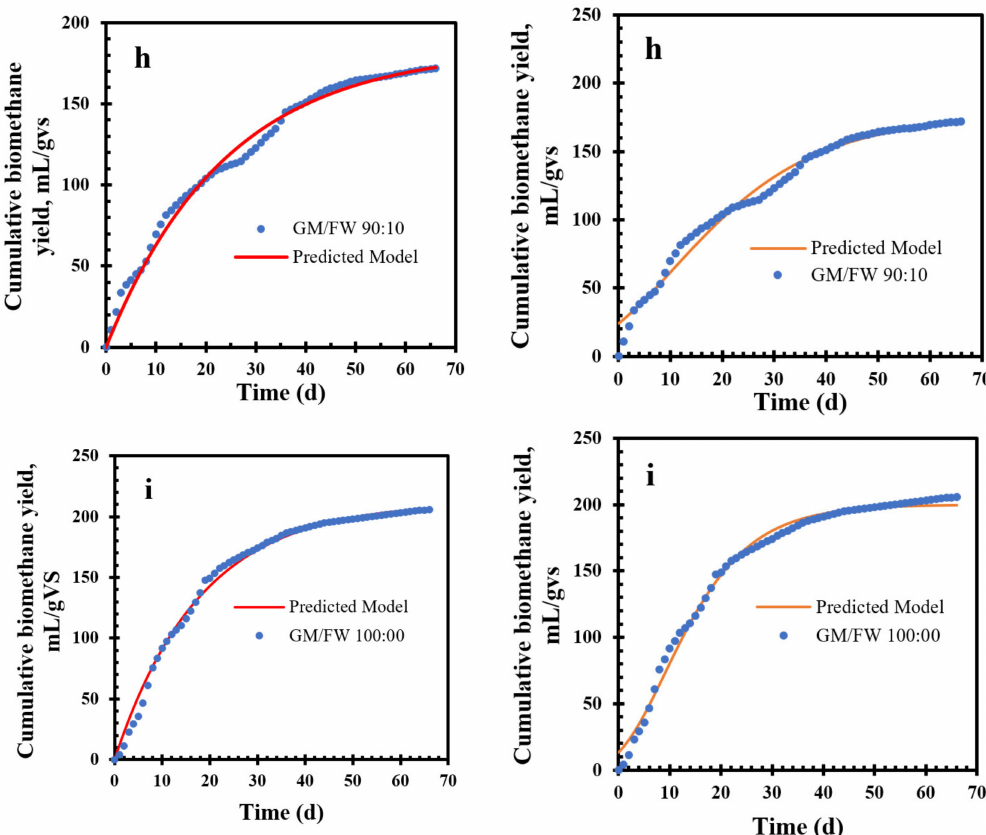
Figure 3. The experimental and predicted biomethane yields for GM/FW ratios; a: 0:100, b: 10:90; c: 30:70; d: 40:60, e: 50:50, f: 60:40, g: 70:30, h: 90:10, i: 100:0 for the first order (left) and modified Gompertz models (right)